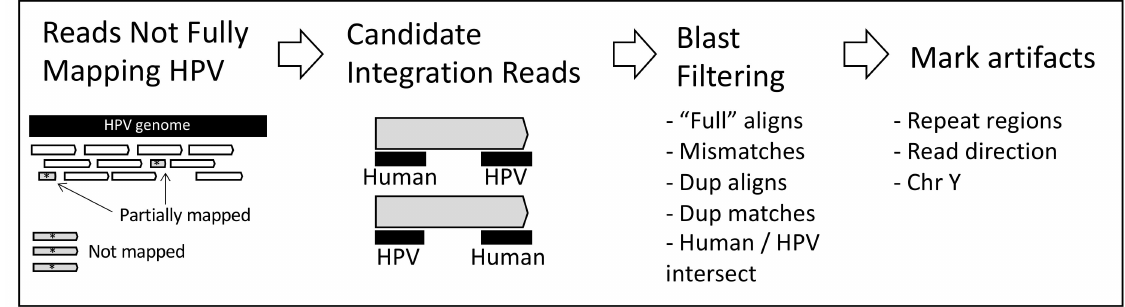
Figure 1. Scheme of the strategy used to identify reads showing evidence of